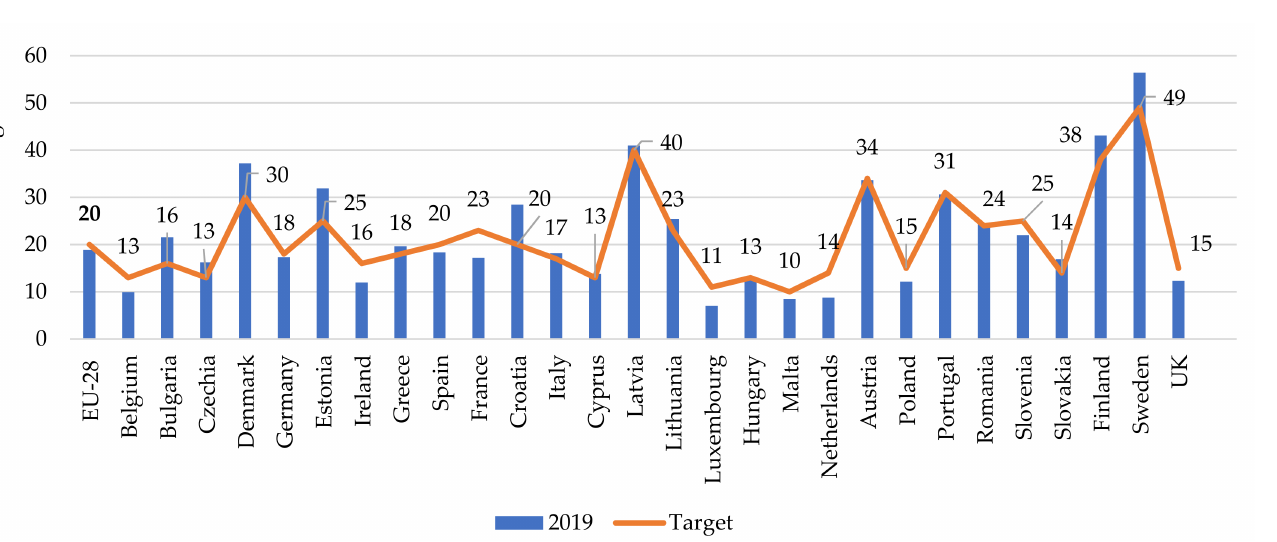
Figure 2. The progress towards Europe 2020 target in share for renewable energies (on the EU level) (developed by the authors based on